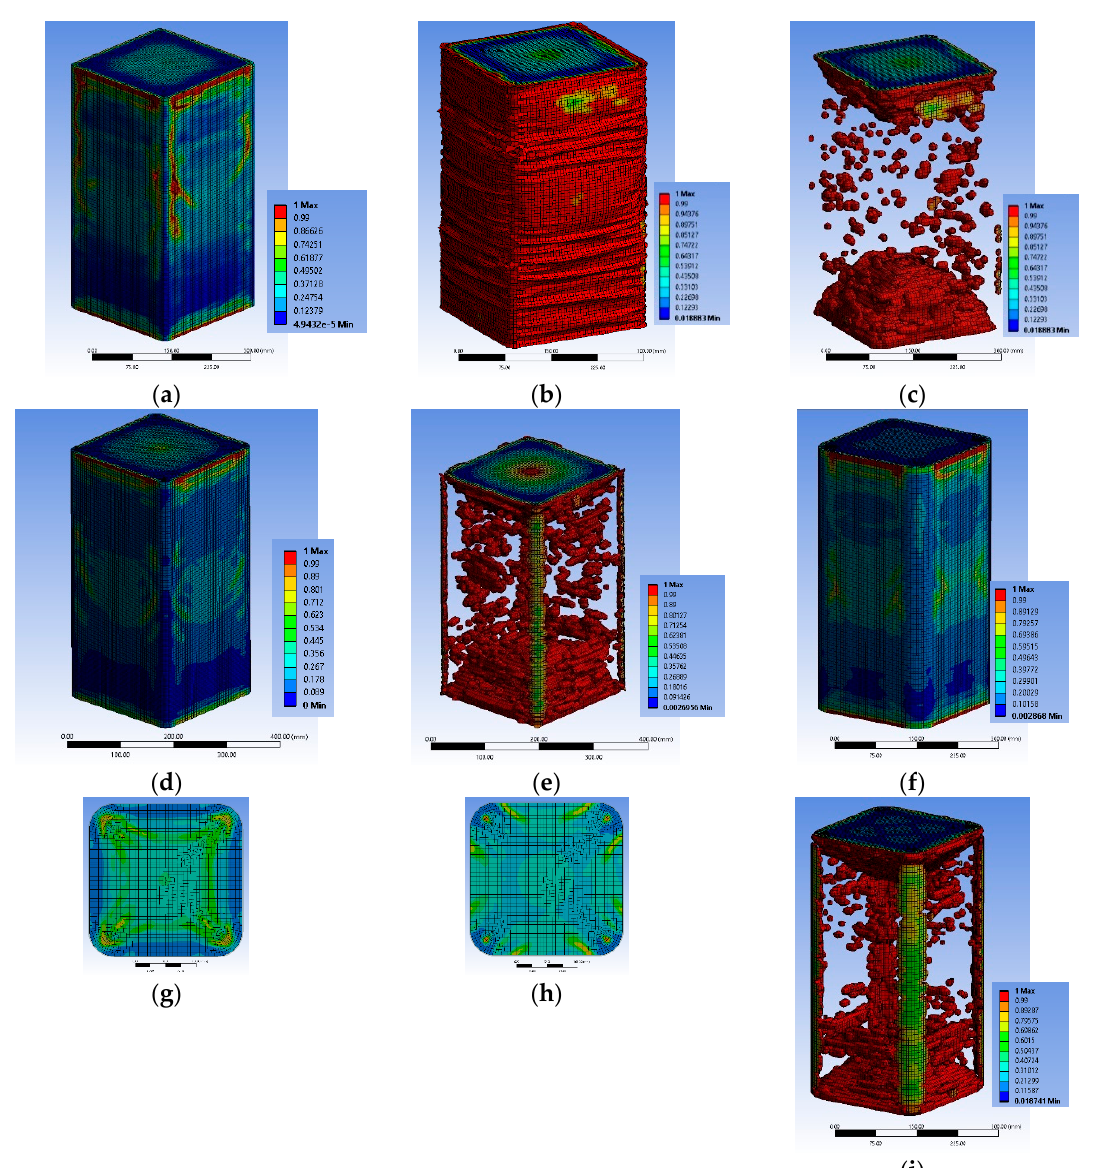
Figure 11. Variation of concrete damage of specimen LSR-R-1-3-10b ( a ) one step after the first concrete damage; ( b ) at the ultimate condition and ( c ) without areas with damage; LSR-R-1-3-20b ( d ) one step after the first concrete damage and ( e ) without areas with damage and LSR-R-1-3-40b ( f ) at the ultimate condition; ( g ) at the level of the stirrup; ( h ) between two stirrups and ( i ) without areas with damage.